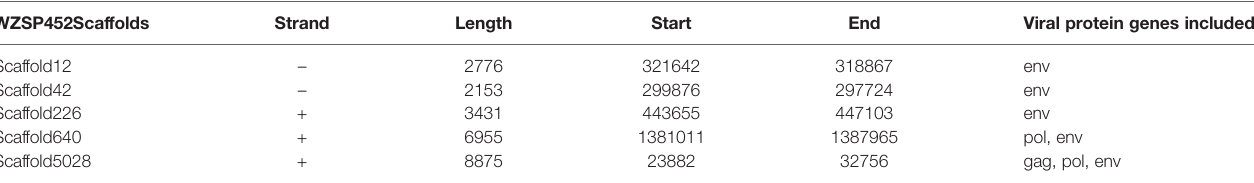
TABLE 3 | Location of PERV genome integrated into the WZSP452 genome. WZSP452Scaffolds